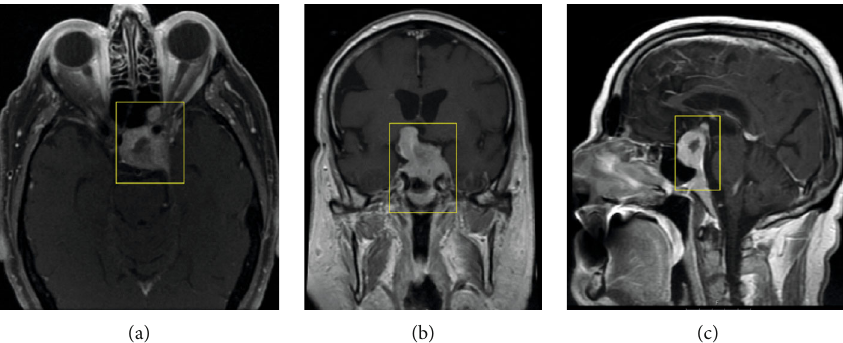
Figure 1: Radiographic imaging, on initial workup of the heterogeneously enhancing eccentric. T1-weighted sequence magnetic resonance imaging with contrast presented in axial, coronal, and sagittal planes, respectively. The mass invades the left cavernous sinus and orbit with envelopment of the left internal carotid artery (a). In the suprasellar region, the mass extends into the right hypothalamus (b) with mass e ff ect on the third ventricle (c). The mass measures 4 : 3x3 : 3x3 : 7cm with a calculated volume of 17.11mL using 3D modelling. Boxes highlight the tumor of interest.